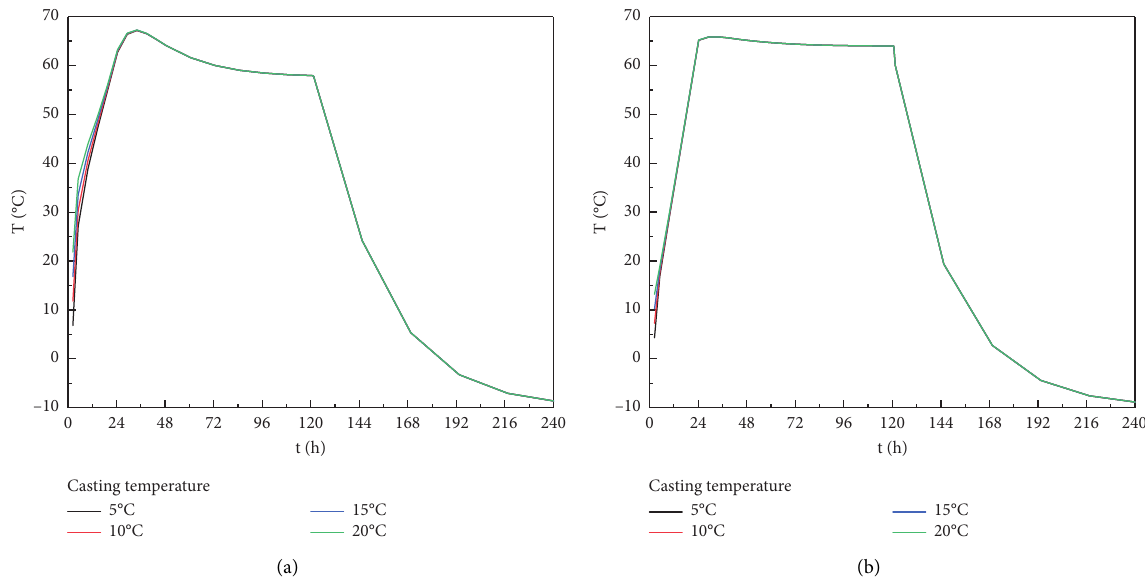
Figure 10: Change in concrete temperature over time according to casting temperature at (a) T3 and (b) T7.